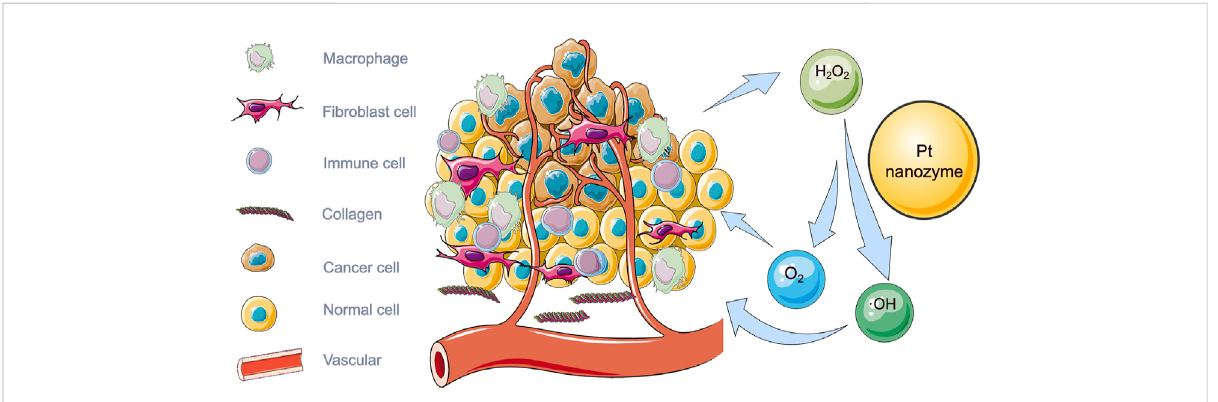
FIGURE 1 Illustration of tumor microenvironment and the catalytic effect of platinum nanozymes on hydrogen peroxide in tumor microenvironment.